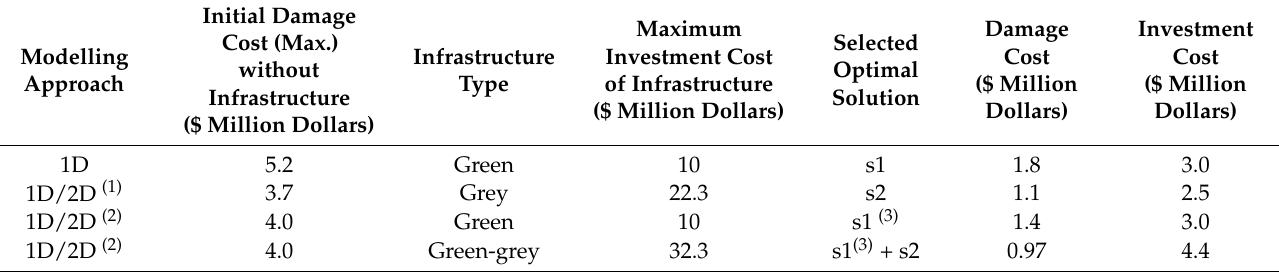
Table 2. Summary of the green-grey infrastructure performance.